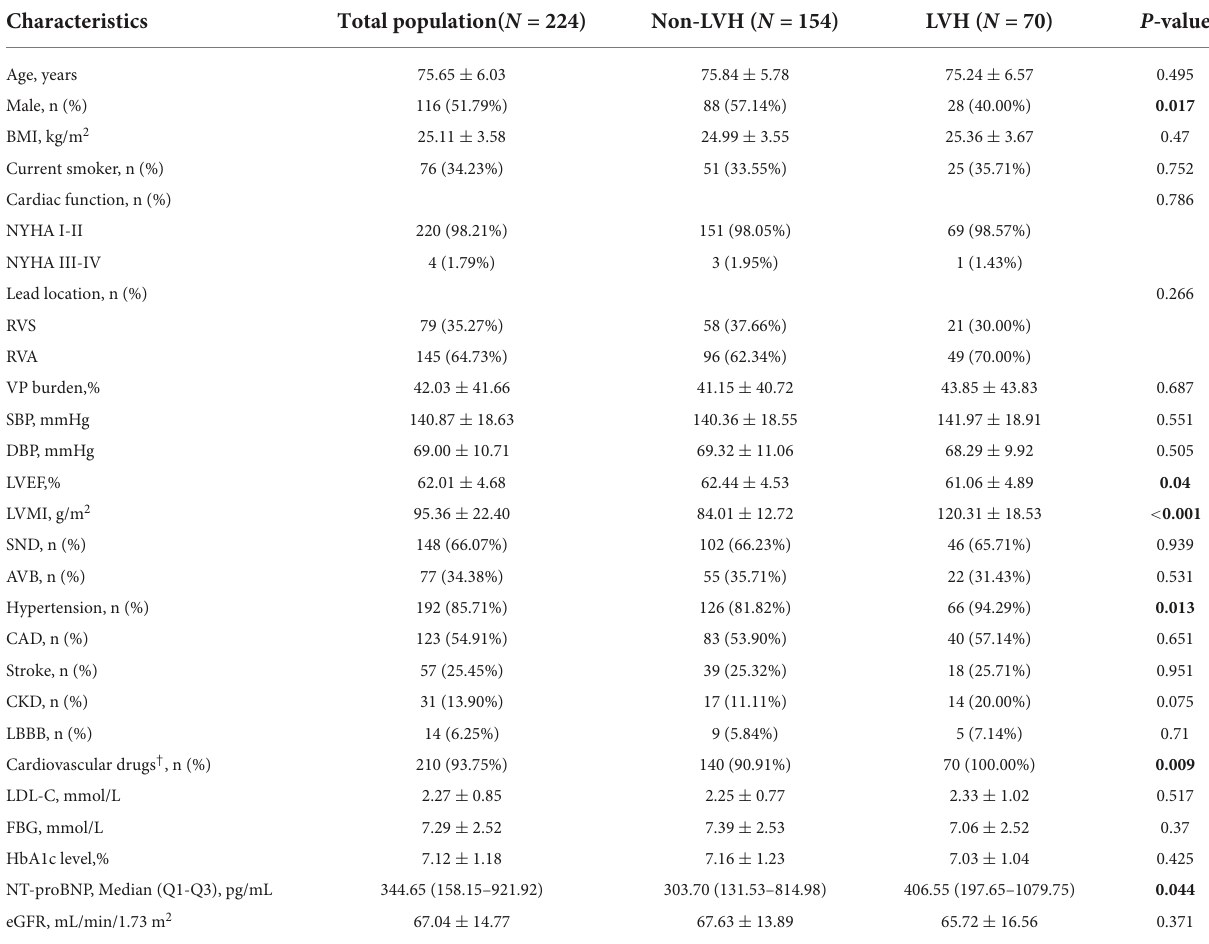
TABLE 2 Baseline characteristics of study participants stratified by